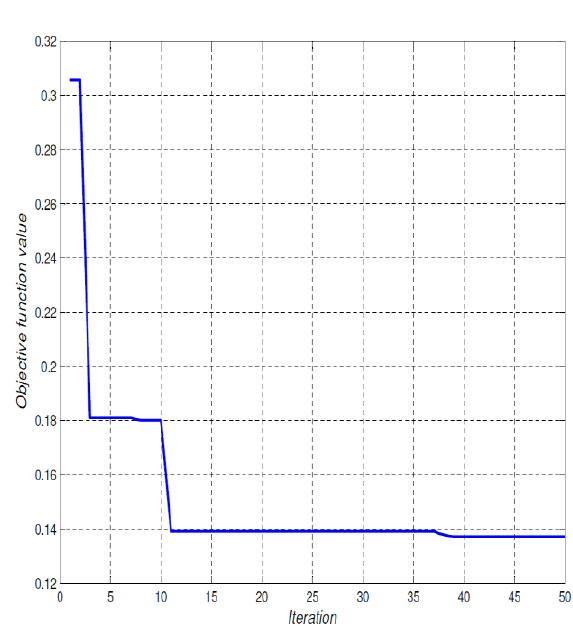
Figure 8. Convergence curves for the objective function with Genetic